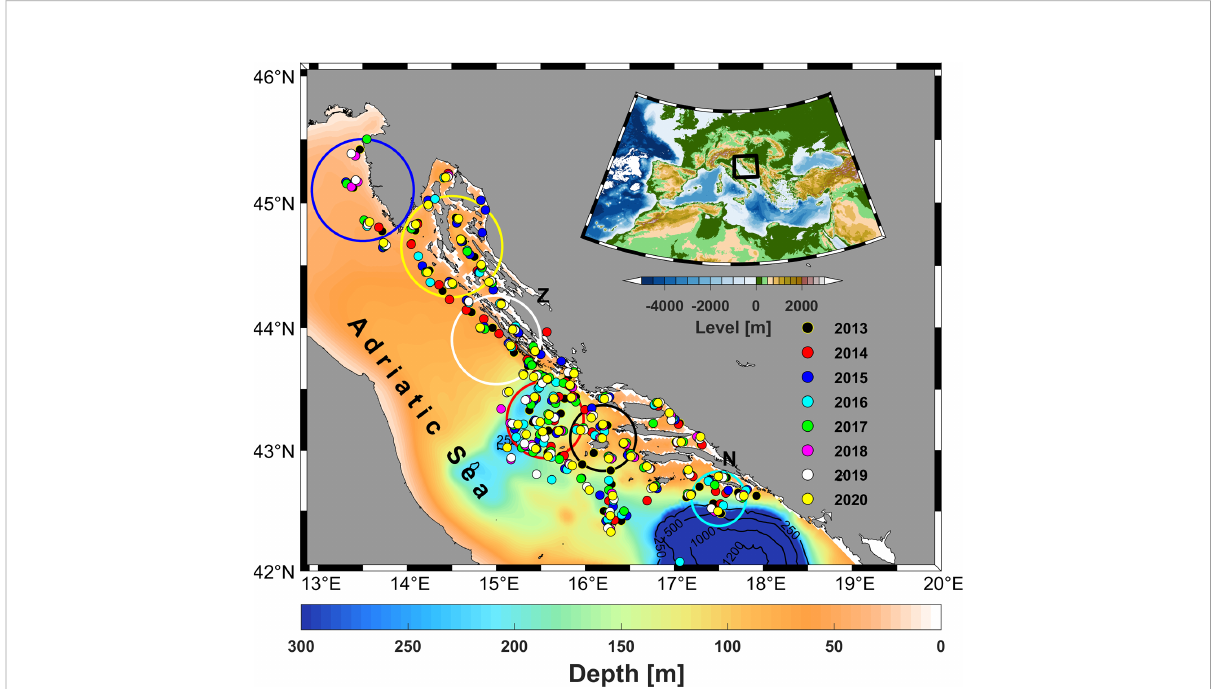
FIGURE 1 Map of the bathymetry of the Adriatic Sea showing the locations of sampling sites for anchovy eggs and larvae collected during the summer surveys from 2013 to 2020 in the eastern Adriatic Sea (Croatian fi shing area), with a map of the bathymetry of the Mediterranean Sea and surrounding topography (upper right corner). Each sampling year is shown in a different color. The area of the west coast of Istria is marked with a blue circle, Kvarner Bay yellow, the area near the Dugi otok white, Jabuka pit red, the area around the island of Vis black and the area around the island of Mljet cyan. The mouth of the river Neretva is marked by a letter N and the mouth of the river Zrmanja by a letter